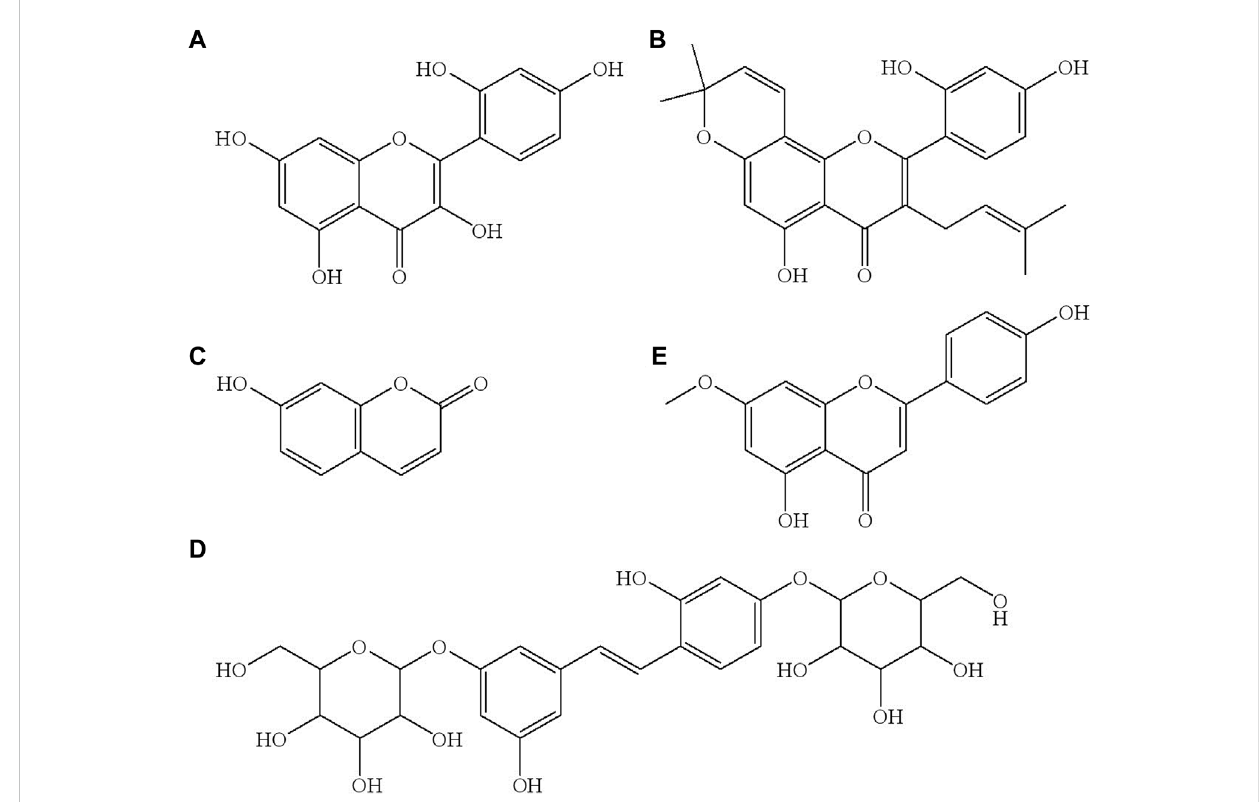
The chemical structure of morin (A) , morusin (B) , umbelliferone (C) , mulberroside A (D) and genkwain IS, (E)